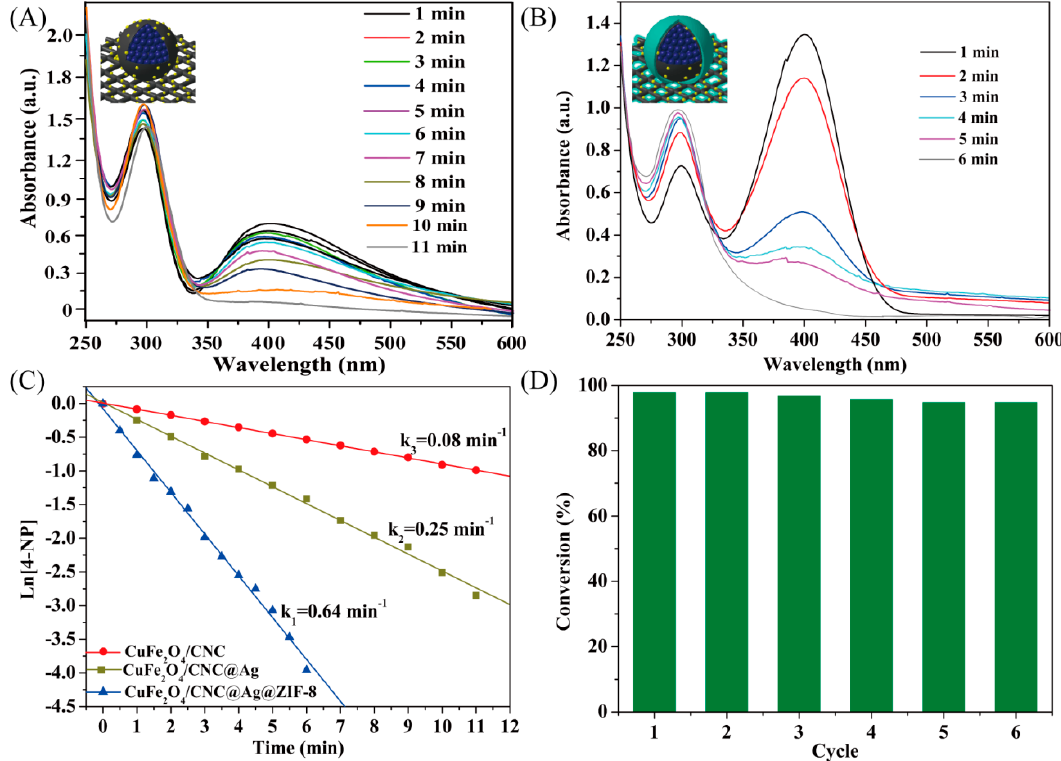
Figure 5. Typical time-dependent evolution of UV–Vis spectra showing the catalytic reduction of 4-NP to 4-AP by ( A ) CuFe 2 O 4 /CNC@Ag; ( B ) CuFe 2 O 4 /CNC@Ag@ZIF-8 nanocomposites; ( C ) plot of ln [4-NP] versus reaction time for the reduction of 4-NP using 3 mg CuFe 2 O 4 /CNC, CuFe 2 O 4 /CNC@Ag, and CuFe 2 O 4 /CNC@Ag@ZIF-8 nanocomposites; ( D ) conversion of 4-NP during six cycles of reaction